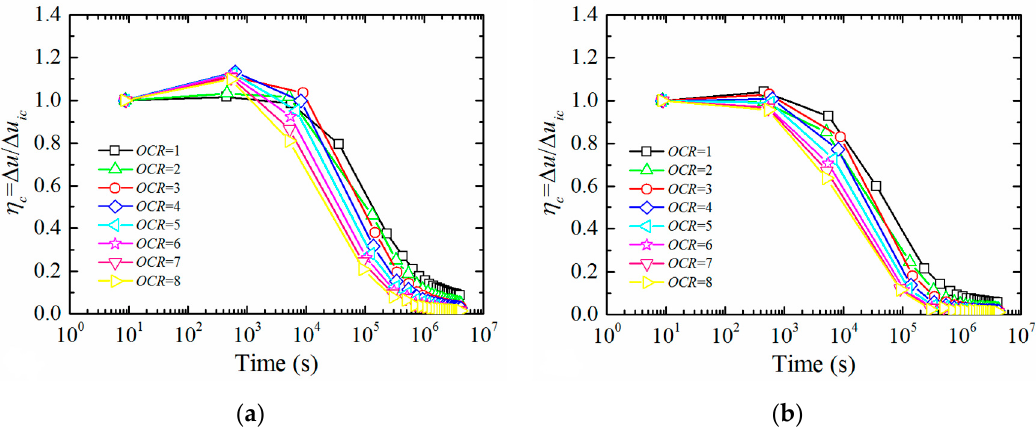
Figure 17. Normalized EPWP dissipation curves after installation under various OCR s. ( a ) At depth of 4.9 m; ( b ) at depth of 7.5 m.